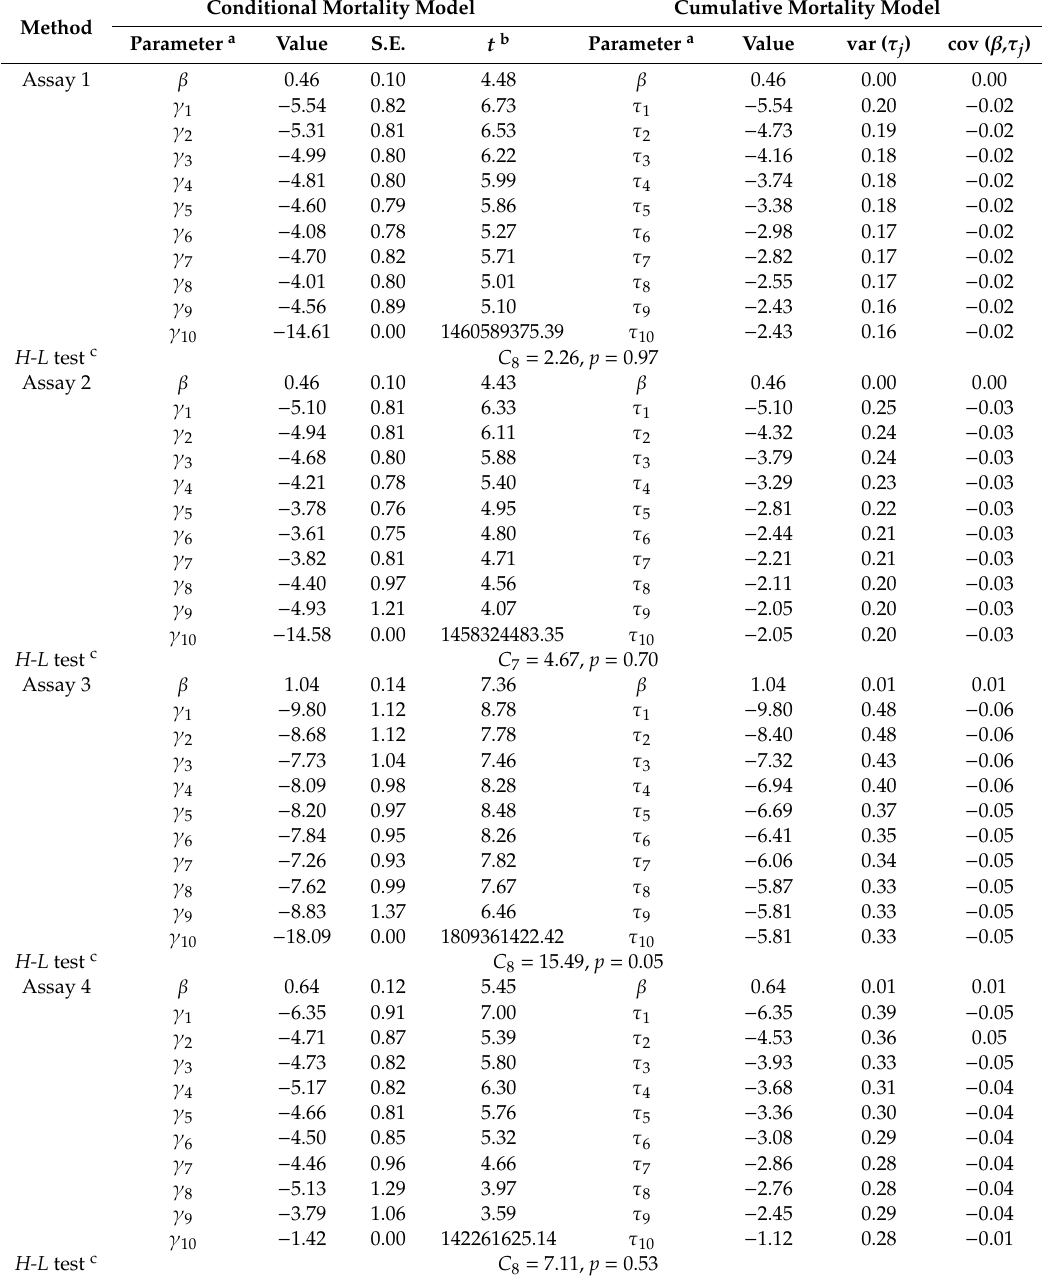
Table 3. Virulence parameters of M. flavoviride WSWL51721 against WFT second instar